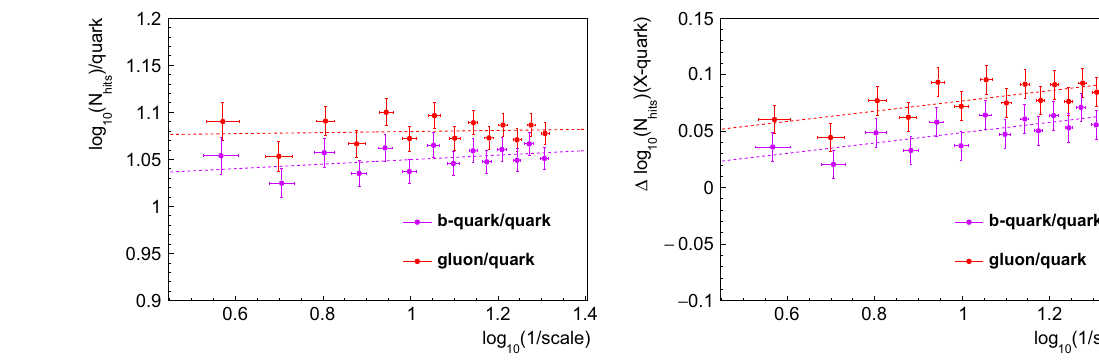
Fig. 3 Left: the ratio of log ( N hits ) with respect to the quark values, for b-quarks and gluons, as a function of log ( 1 /(cid:4)) . A linear fit is added for comparison. Right: the difference of log ( N hits ) with respect to the quark values, for b-quarks and gluons. In the Modified Leading Loga- rithmic Approximation (MLLA), the differences in hadron multiplicity